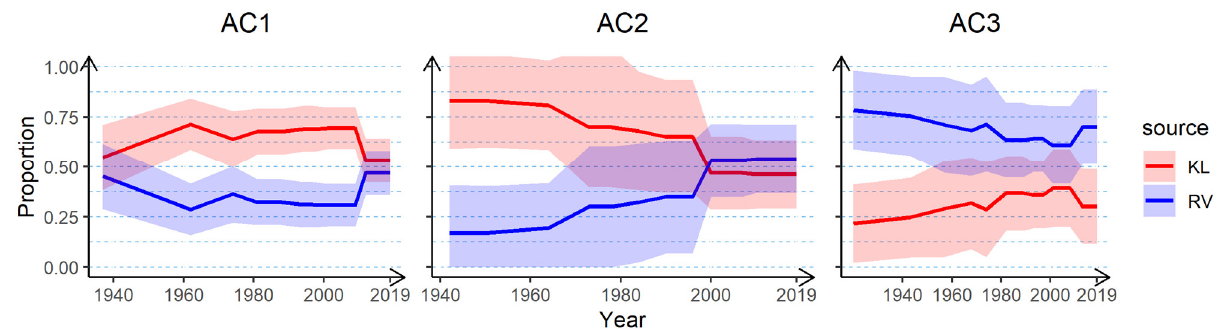
Figure 7. Changing proportional sediment contributions of tributary rivers over time to cores AC1, AC2 and AC3, based on age estimates from the standard CRS model used here as relative age markers.